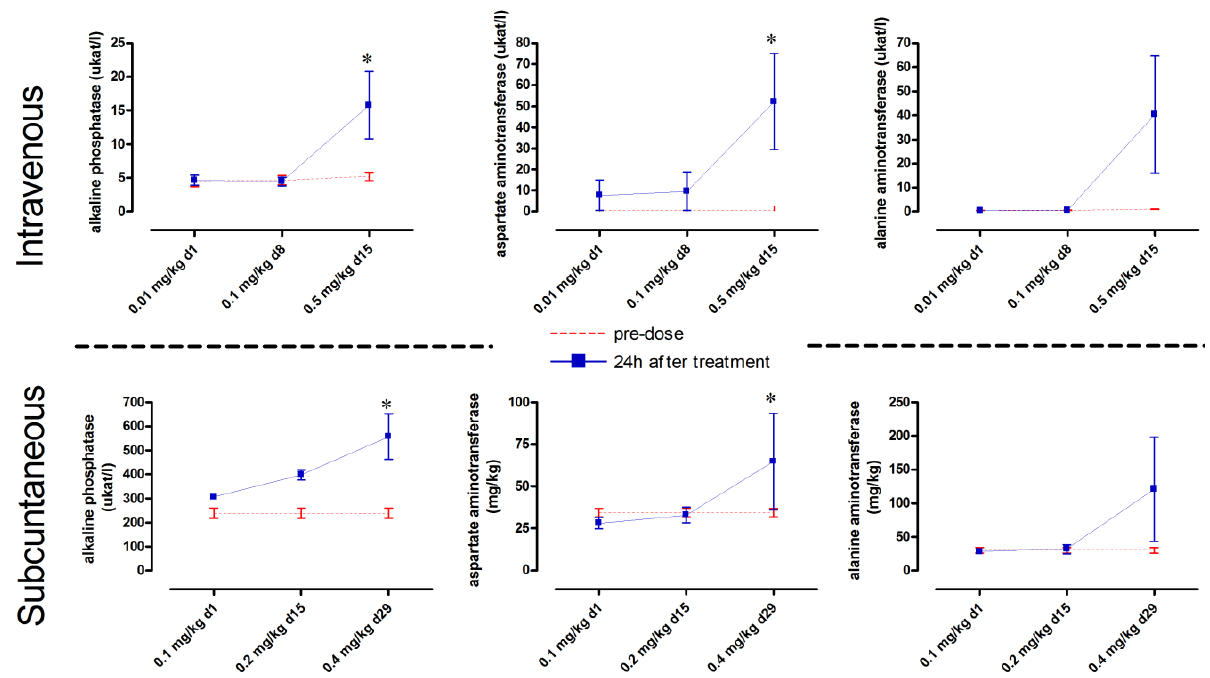
Figure 3. Monitoring of the liver enzymes alkaline phosphatase, aspartate aminotransferase and alanine aminotransferase) in dogs measured 24 h after (i) intravenous (IV) administration of weekly incremental doses of 0.01, 0.1 and 0.5 mg/kg (n = 4) and (ii) subcutaneous (SC) administration of weekly incremental doses of 0.1, 0.2 and 0.4 mg/kg (n = 4) * p < 0.05 (Two-way ANOVA with Bonferroni post-hoc )